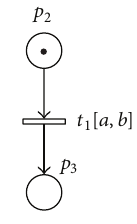
[0, 2] . Figure 10: A simple time Petri net ( 𝑇 𝑐 = {𝑡 1 })